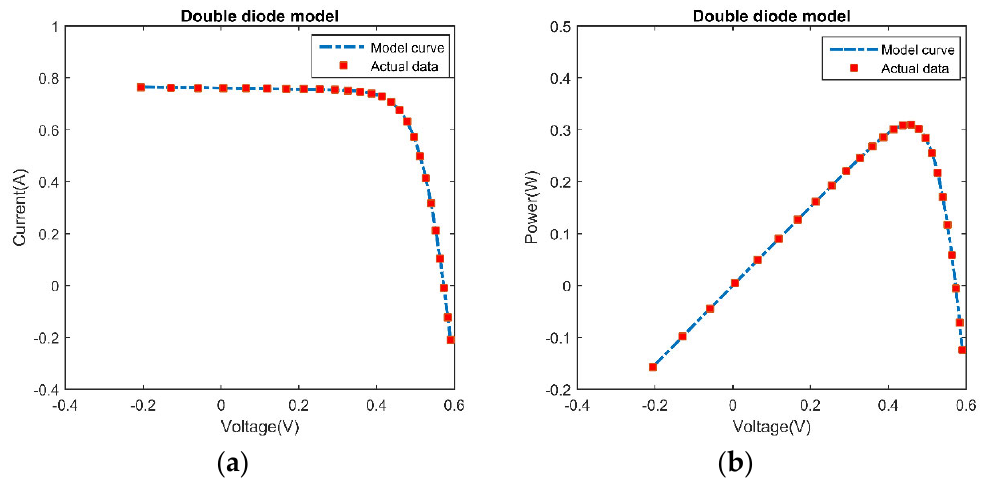
Figure 8. Output I ‐ V and P ‐ V curves obtained by ARO: ( a ) I ‐ V curve; and ( b ) P ‐ V curve. Figure 8. Output I-V and P-V curves obtained by ARO: ( a ) I-V curve; and ( b ) P-V curve. The output I-V and P-V curves obtained by ARO are illustrated in Figure 8. The Convergence speed and stability are both important criteria for measuring the per- actual data are acquired from the experiment conducted in literature [38] published in formance of an optimization method. The convergence curves of the RMSE of WOA, ABC, 1986, where a 57 mm diameter commercial silicon solar cell (R.T.C. France) operating under and ARO for DDM are demonstrated in Figure 9. Although WOA and ABC converge G = 1000 W/m 2 at T = 33 ◦ C, with a CBM 8096 microcomputer acting as the controller. su ff er from prematurity, leading to low-quality local optimums. However, ARO tends to have a higher quality global optimum and a more stable convergence process due to its adaptive adjustment between global exploration and local exploitation throughout the it- eration, thus avoiding falling into a local optimum.